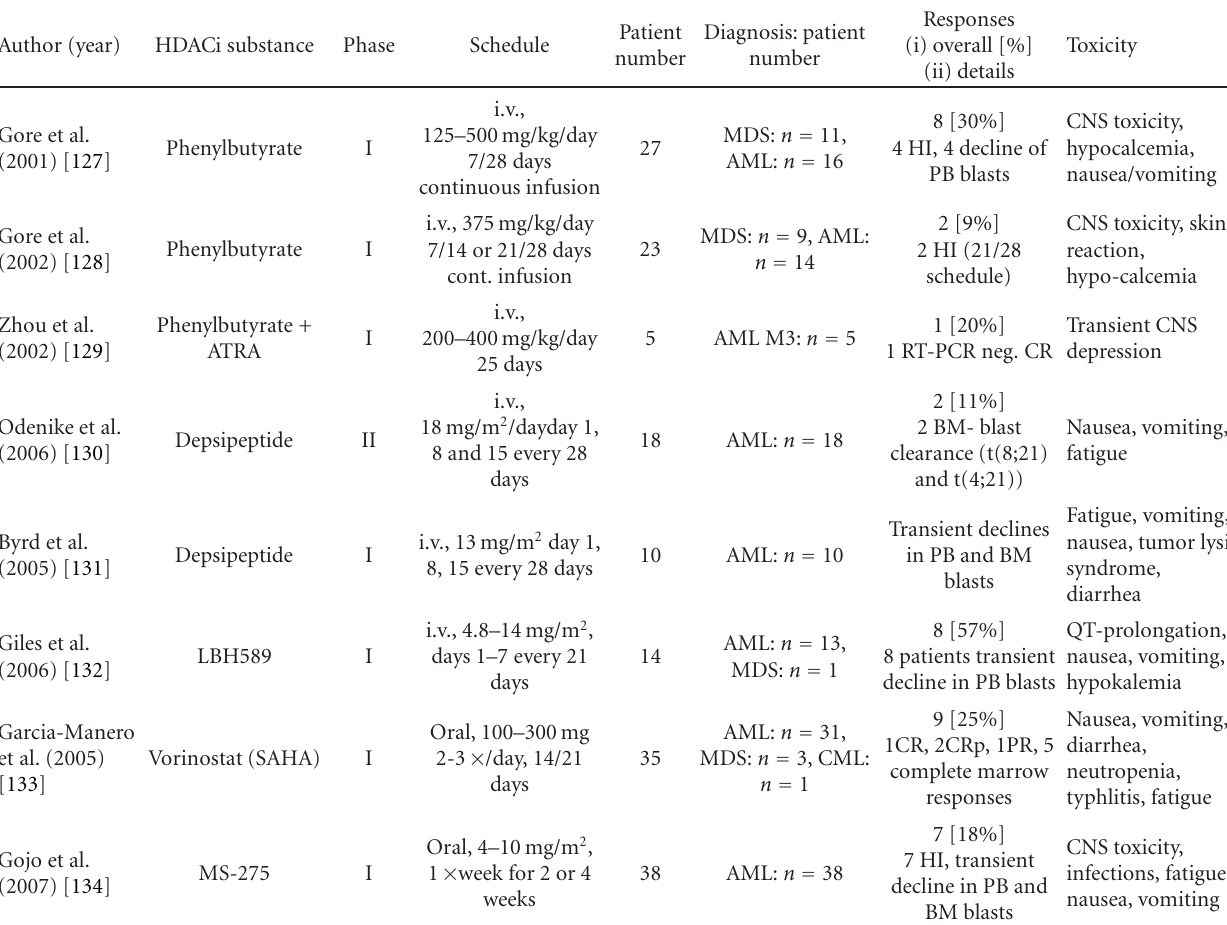
Table 3: Clinical trials of HDACi in MDS and AML (adapted and extended from [15, 17]; see also current and ongoing clinical trials at